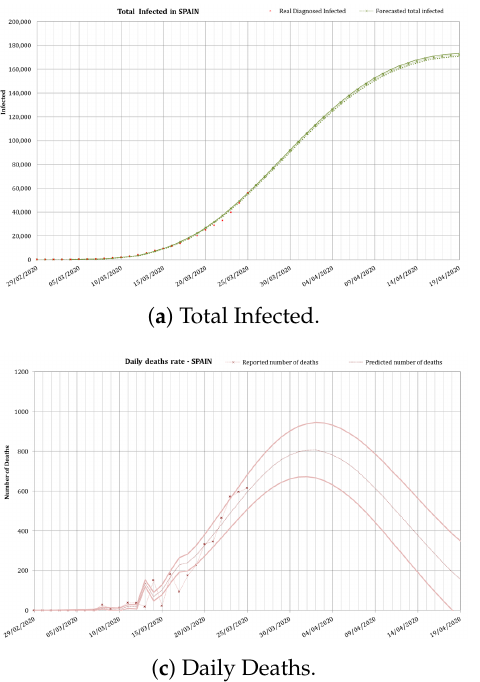
Figure 7. Total number of infected (a) , total deaths (b) and daily deaths (c) in Spain predicted from the 29 February/19 April. These second modelled results assumed the total lock-down since the 15 March and were calibrated with data up to the 25 March. Red dots—reported data. Green bars—modelled values with